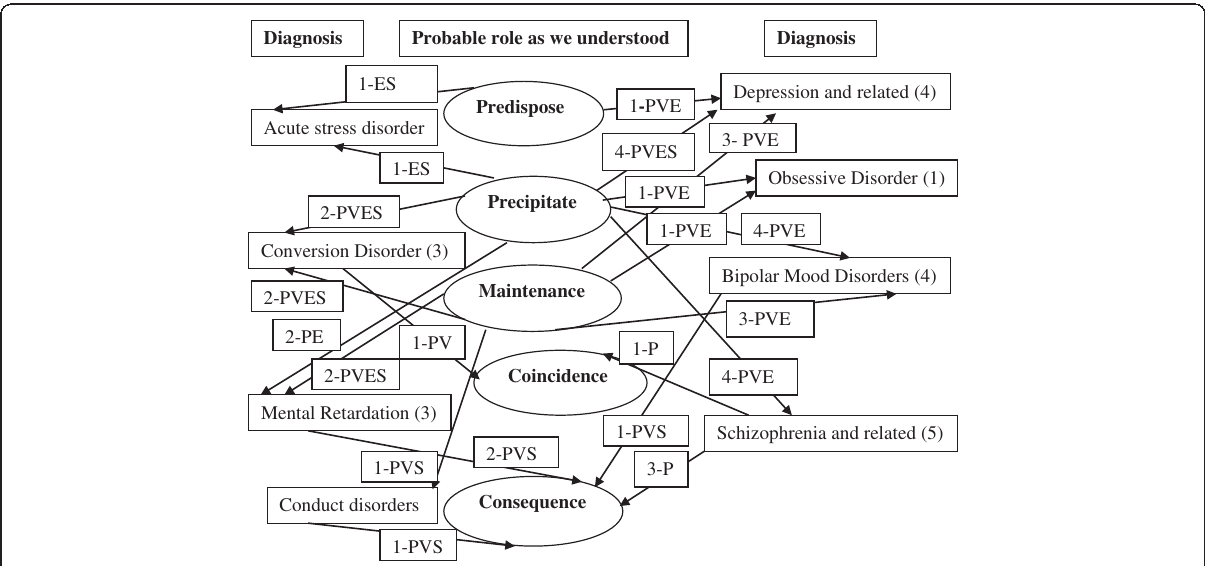
Fig. 1 Role of different types of violence in different types of mental disorders as we understood. P physical, S social, V verbal, E emotional or psychological. Note, the numbers indicate the count of patients for descriptive purpose, the arrows indicate towards the types of relationship while the types of violence were placed on the arrows to illustrate what types of violence were associated with that